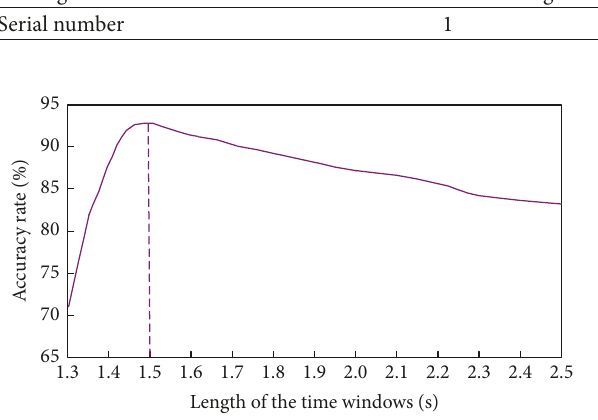
Figure 9: Calibration of the identification time